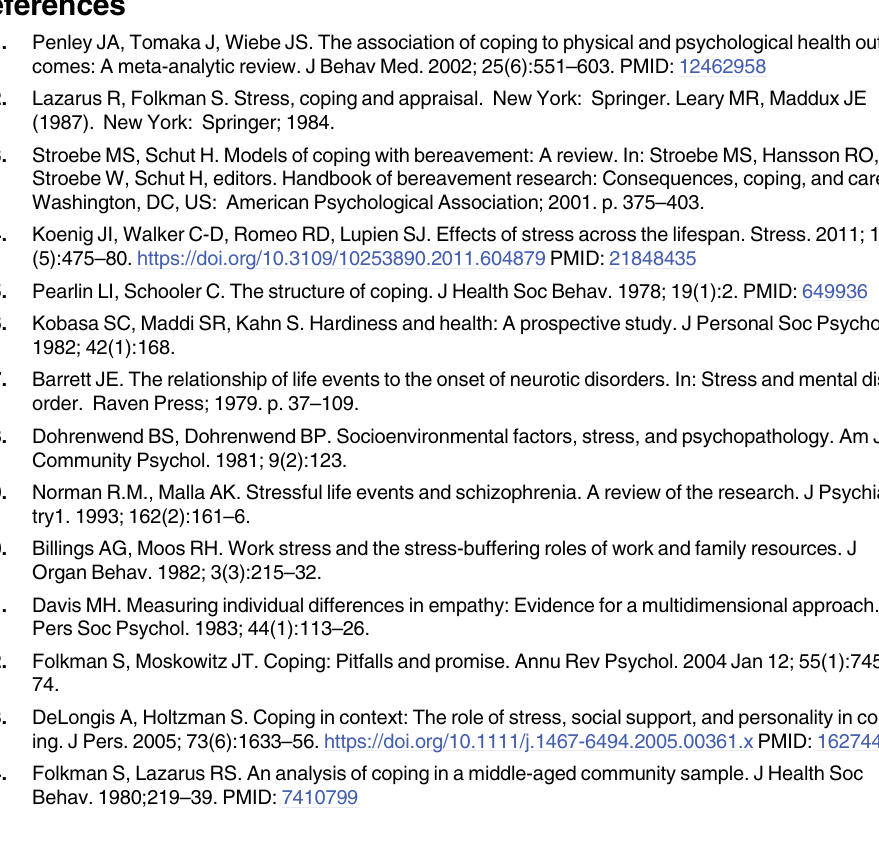
S9 Fig. Relationship between empathy and maladaptive coping in Study 4. (TIFF) S10 Fig. Interaction between genotype and SES on social support in Study 5.